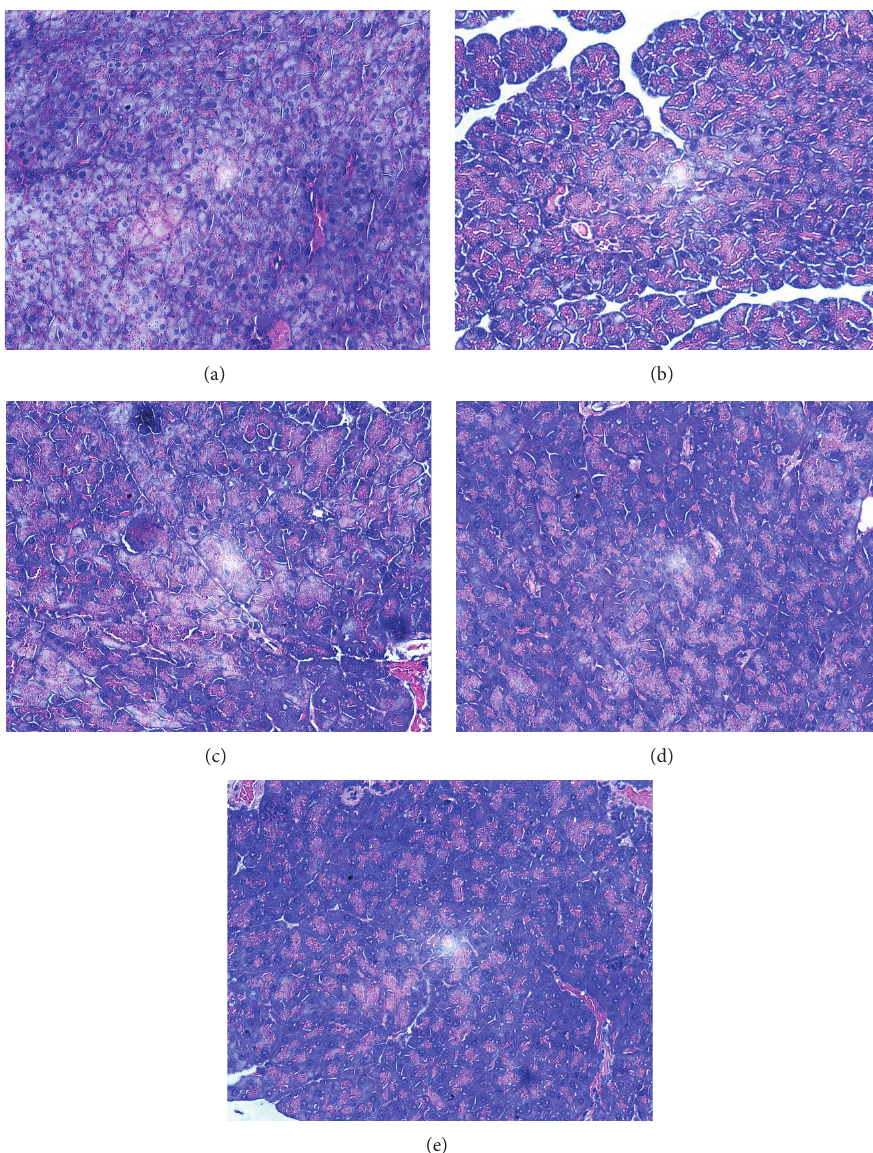
Figure 5: Effects of BBE on pathologic tissue in the pancreas of STZ-induced diabetic mice. (a) Normal group; (b) diabetes model control group; (c), (d), and (e) STZ-induced diabetic mice treated with 50, 100, and 200 mg/kg ⋅ BW of BBE,